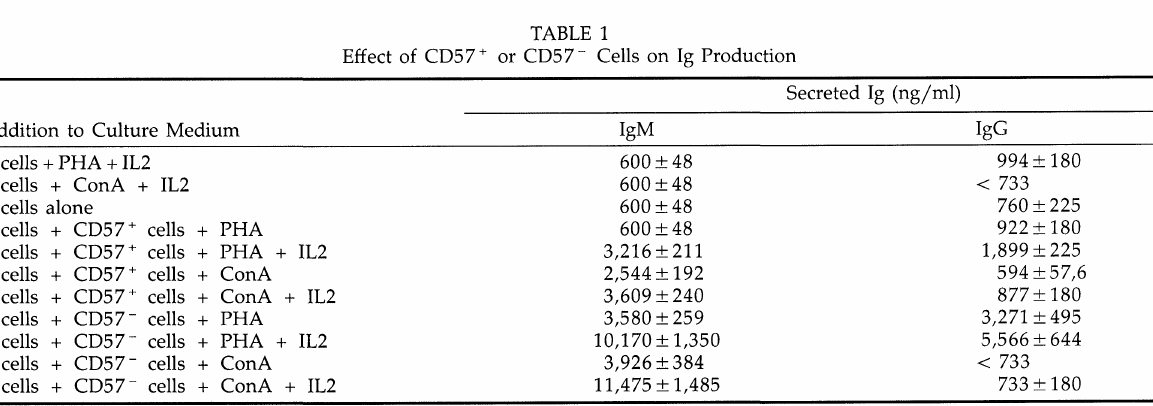
TABLE Effect of CD57 or CD57- Cells on Ig